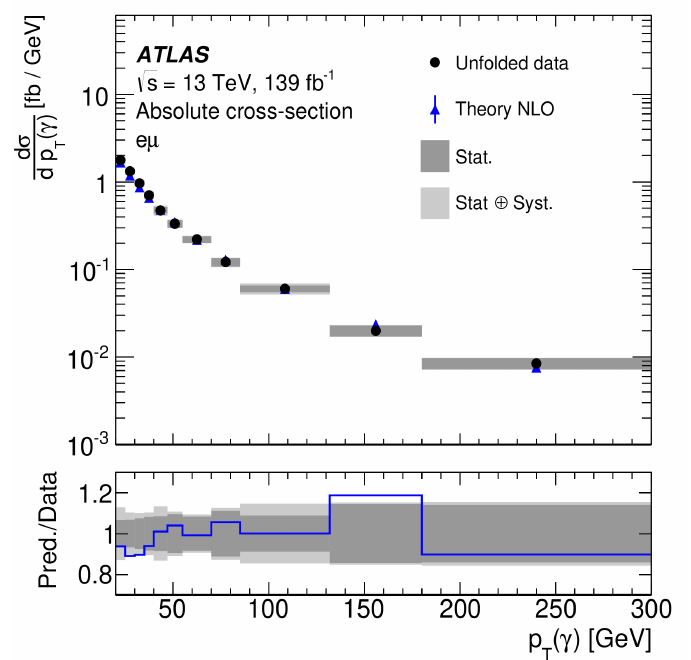
Figure 23. Distribution of the absolute production cross − section of t ¯ t γ in the e µ channel as a function of the p T of the photon, as measured by the ATLAS experiment [49]. Observed data unfolded to parton level is compared with the predicted distribution from the theoretical prediction from [50,51]. The systematic and statistical uncertainties are shown in the grey